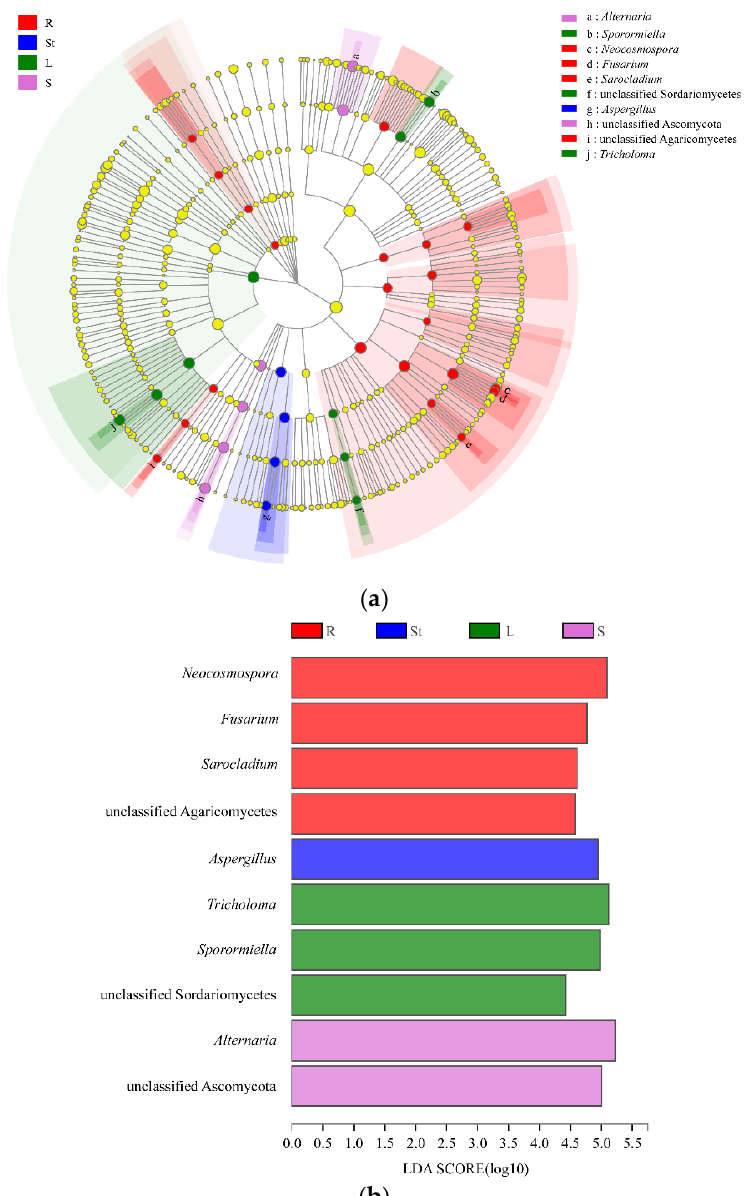
Figure 4. Biomarkers in different organs of S. alopecuroides : ( a ) LEfSe was used to identify the most differentially abundant taxa among four organs of S. alopecuroides . Cladogram generated by LEfSe indicating differences between the four organs at phylum, class, order, family, and genus levels. Each successive circle represents a phylogenetic level. Color regions indicate taxa enriched in the different organs. Differing taxa are listed on the right side of the cladogram. ( b ) Bar graph showing LDA scores for fungal taxa; only taxa meeting an LDA significant threshold >2 are shown.